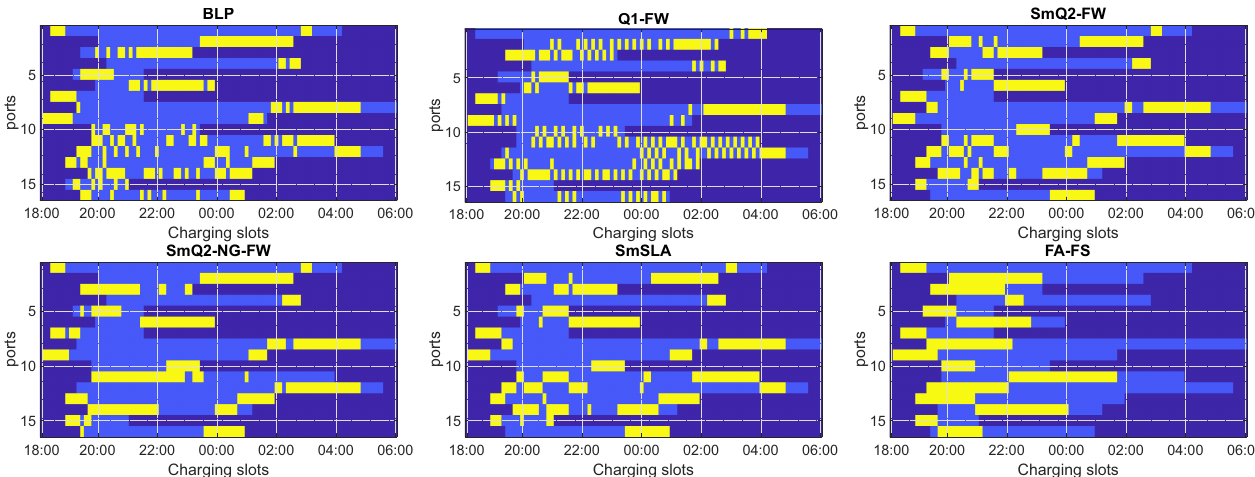
Figure 2. One MC run of charging schedules obtained with the tested algorithms for N = 16 and random charging rates. Charging slots are in yellow, available time slots are in light blue, and unavailable time slots are in dark blue.